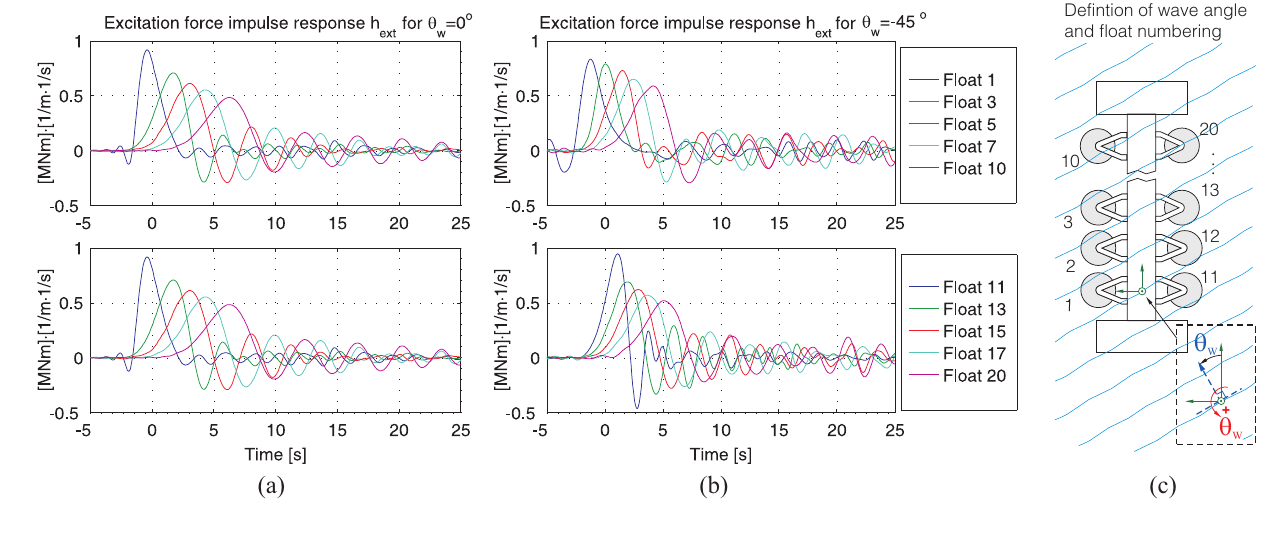
, for different floats. ( a ) is ext = 45 ◦ ; and ( c ), the wave w − , are defined. w